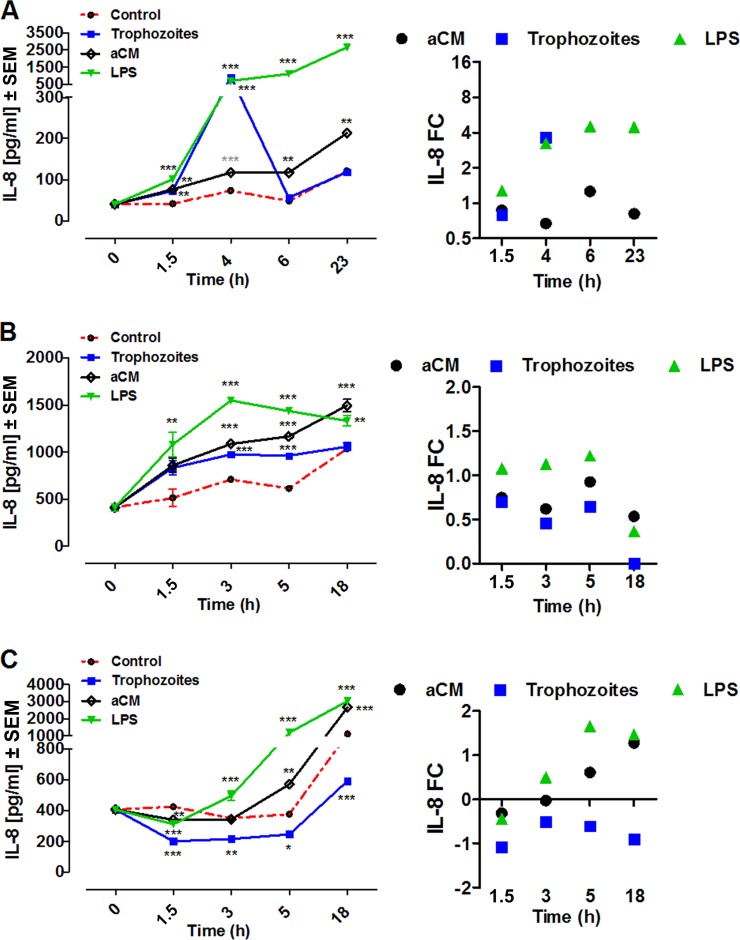
IL-8 production by THP-1 (A), PBMCs (B), and MDMs (C) after coincubation with trophozoites of A. castellanii (trophozoites) or stimulation with aCM. A total of 2 × 105 of either target cells were challenged with either 2 × 104 trophozoites, ratio of 10:1, or with 800 μl of aCM (final dilution of 4:5 in the culture medium). IL-8 concentration in THP-1 experimental supernatants was evaluated at 1.5, 4, 6, and 23 h poststimulation, whereas in both PBMCs and MDMs experimental supernatants it was evaluated at 1.5, 3, 5, and 18 h poststimulation. All three cellular models were stimulated with 10 ng/ml LPS as a positive control, whereas unstimulated cells (control) were considered the negative control. Experiments were performed in triplicate and repeated at least 3 times. Results represent the mean values ± SEM of either n = 5 (THP-1) or n = 3 (PBMCs and MDMs) samples. One-way ANOVA was applied for each time points. Dunnett's multiple-comparison test was performed to evaluate differences between the experimental condition means and the control at each time point. In the graphs, significances between the experimental conditions and the control are indicated as P values of <0.05 (*), <0.005 (**), and <0.0001 (***). Student t test was also applied at each time point to verify the significance of single pairs of means (single experimental condition versus control). In the graphs, significances between the experimental condition and the control, obtained with Student t test, are indicated as a P value of <0.0001 (***). On the right, the same results are expressed as fold change (FC) over the unstimulated cells.